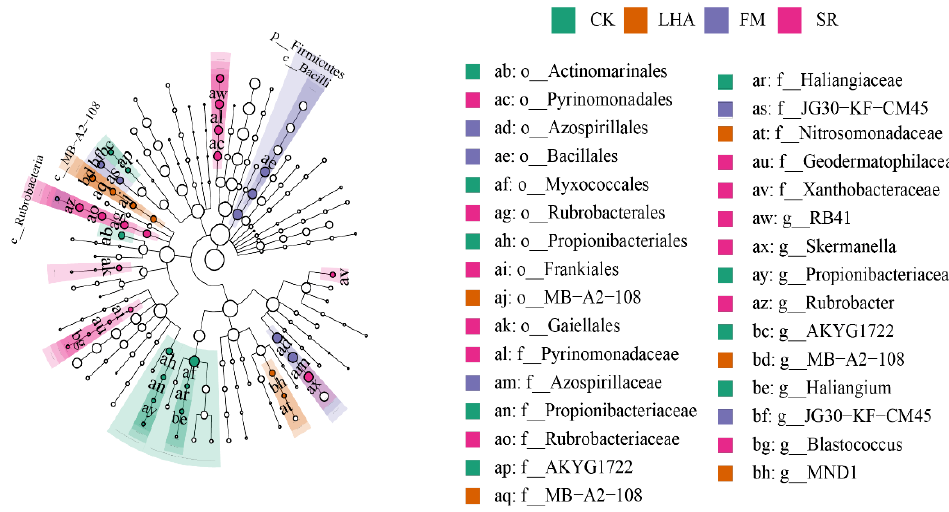
Figure 3. Linear discriminant analysis effect size (LEfSe) analysis to identify differences in abundant taxa between different treatment samples.